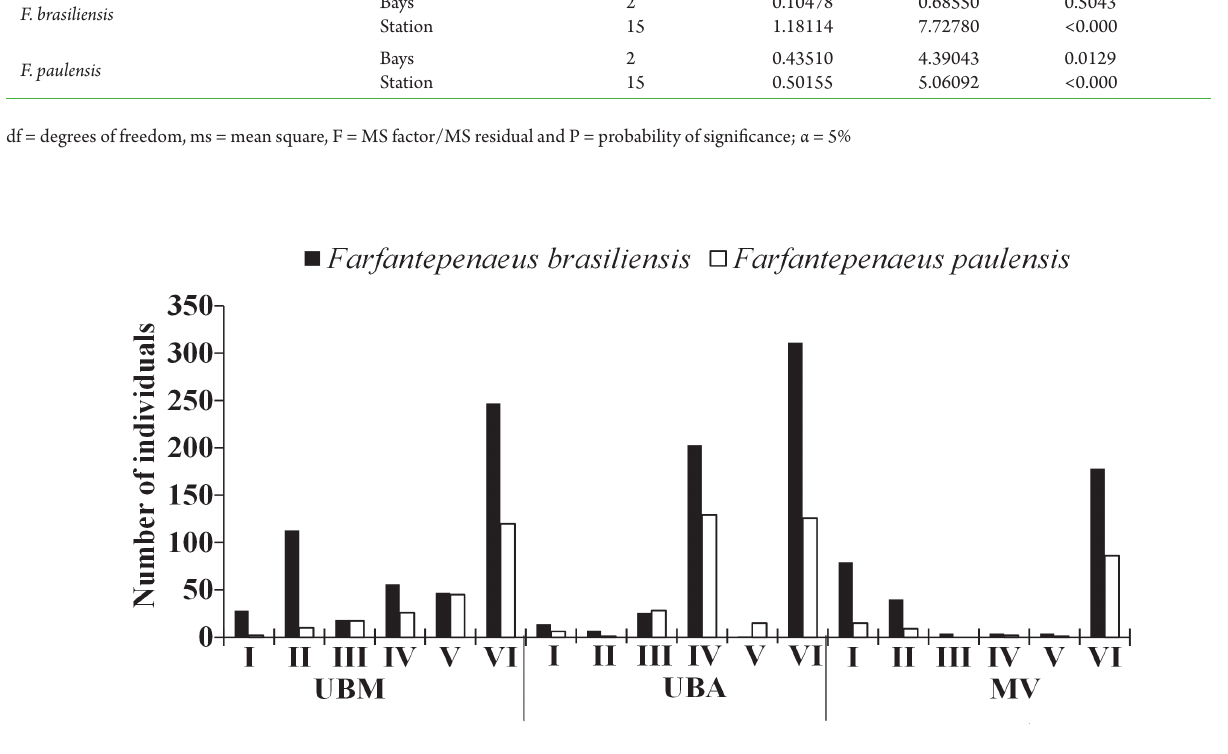
Table 3. Results of Nested ANOVA for the number of individuals (log + 1 transformed) of Farfantepenaeus brasiliensis and F. Species Source of variation df ms F P